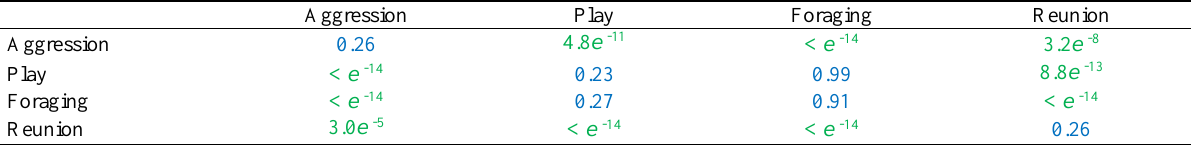
The p-values for the statistical testing experiment using the combined dataset and the exact algorithm Aggression Play Foraging Reunion Aggression 0.51 Play < e -14 0.79 0.01 Foraging < e -14 < e -14 0.98 Reunion 3.00 e -9 < e -14 0.84 significant after correction are shown in